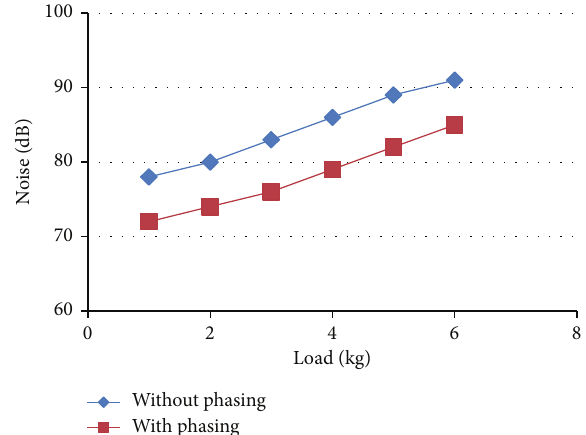
Figure 12: Variation of noise (dB) with frequency (Hz) at 1200rpm 1Kg load.